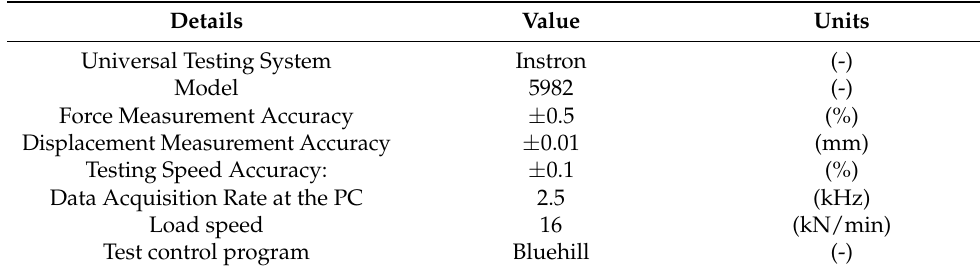
Table 5. Basic information about the instrument and